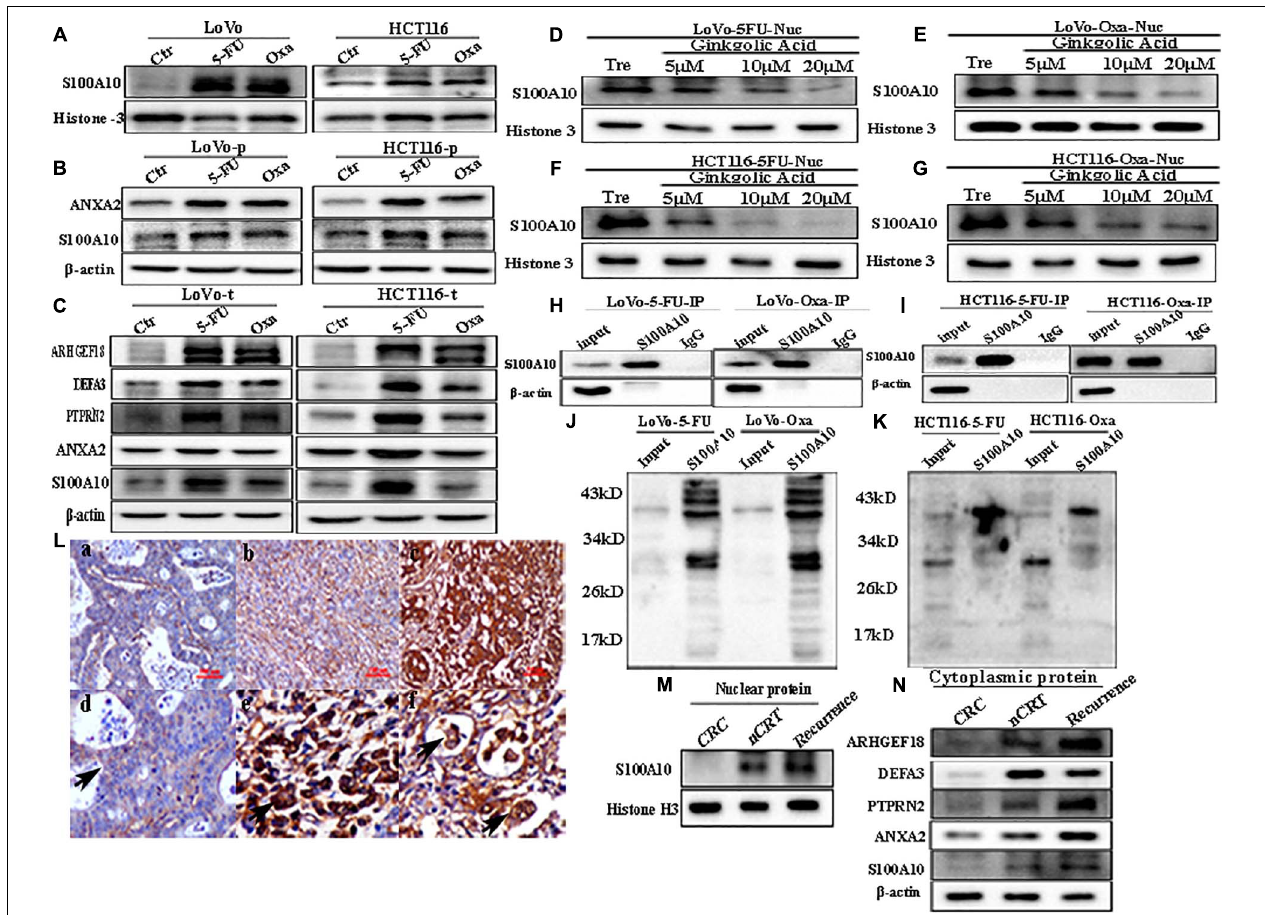
FIGURE 6 | (A) Nuclear S100A10 expression in LoVo and HCT116 cells before and after treatment with 5-Fu and Oxa, respectively. (B) Cytoplasmic ANXA2 and S100A10 expression in LoVo and HCT116 cells before and after treatment with 5-Fu and Oxa, respectively. (C) Total ANXA2, S100A10, ARHGEF18, DEFA3, and PTPRN2 expression in LoVo and HCT116 cells before and after treatment with 5-Fu and Oxa, respectively. (D) Nuclear S100A10 expression in 5-Fu-treated LoVo cells after GA treatment at 0, 5, 10, and 20 µ M for 24 h. (E) Nuclear S100A10 expression in Oxa-treated LoVo cells after GA treatment at 0, 5, 10, and 20 µ M for 24 h. (F) Nuclear S100A10 expression in 5-Fu-treated HCT116 cells after GA treatment at 0, 5, 10, and 20 µ M for 24 h. (G) Nuclear S100A10 expression in Oxa-treated HCT116 cells after GA treatment at 0, 5, 10, and 20 µ M for 24 h. (H) Results of S100A10 co-immunoprecipitation in LoVo cells after treatment with 5-Fu and Oxa, respectively. (I) Results of S100A10 co-immunoprecipitation in HCT116 cells after treatment with 5-Fu and Oxa, respectively. (J) Total lysates of LoVo cells after treatment with 5-Fu and Oxa were immunoprecipitated with anti-S100A10 and immunoblotted with anti-SUMO1, respectively. (K) Total lysates of HCT116 cells after treatment with 5-Fu and Oxa were immunoprecipitated with anti-S100A10 and immunoblotted with anti-SUMO1, respectively. (L) IHC staining of S100A10 in the human CRC tissues. (a) S100A10 expression in the well-differentiated CRC tissue (IHC, 200 × ). (b) S100A10 expression in the moderately differentiated CRC tissue (IHC, 200 × ). (c) S100A10 expression in the poorly differentiated CRC tissue (IHC, 200 × ). (d) Cytoplasmic expression of S100A10 in CRC cells (Black arrow heads, IHC, 400 × ). (e) Nuclear staining in cancer cells expressing S100A10 in CRC tissues (Black arrow heads, IHC, 400 × ). (d) Cytoplasmic and nuclear expression of S100A10 in PGCCs of CRC tissues (Black arrows head, IHC, 400 × ). (M) Nuclear expression of S100A10 in samples from patients (radical operation) treated with neoadjuvant chemoradiation (nCRT), those not treated with nCRT (CRC) and recurrent liver metastases. (N) Cytoplasmic expression of ANXA2, S100A10, ARHGEF18, DEFA3, and PTPRN2 in samples from patients (radical operation) treated with neoadjuvant chemoradiation (nCRT), those not treated with nCRT (CRC) and those with